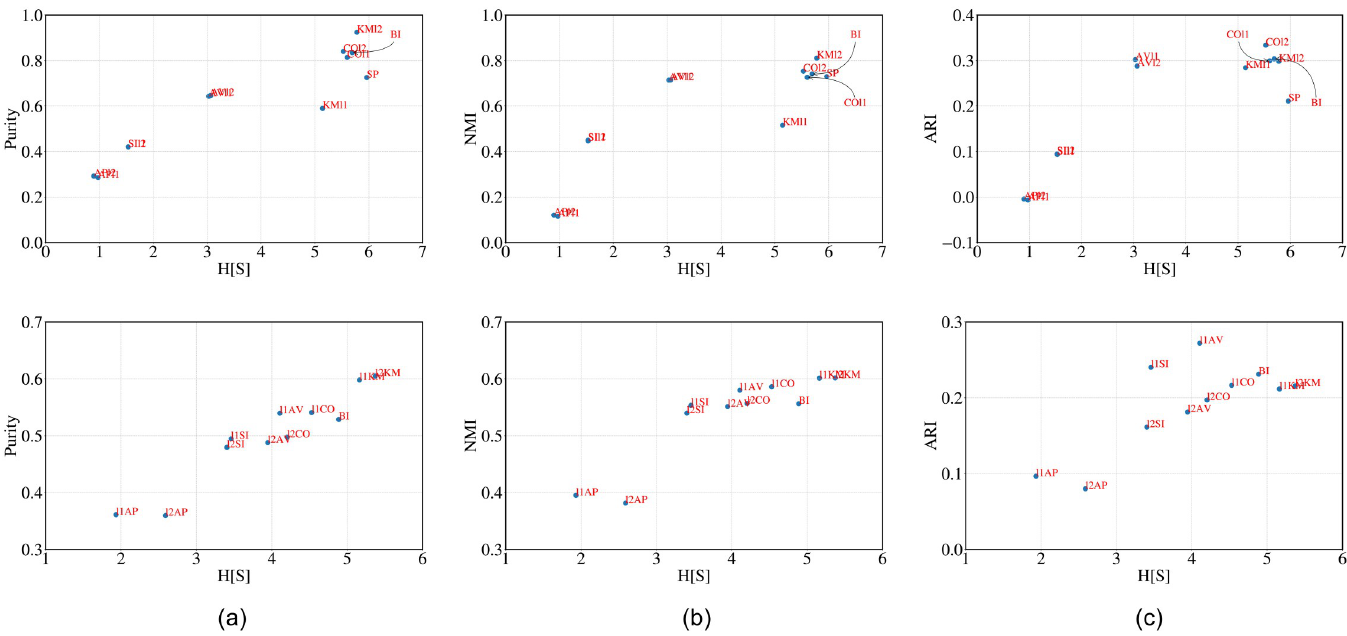
Fig 7. H[S] versus purity, NMI and ARI for Synthetic (top) and Protein (below) datasets.